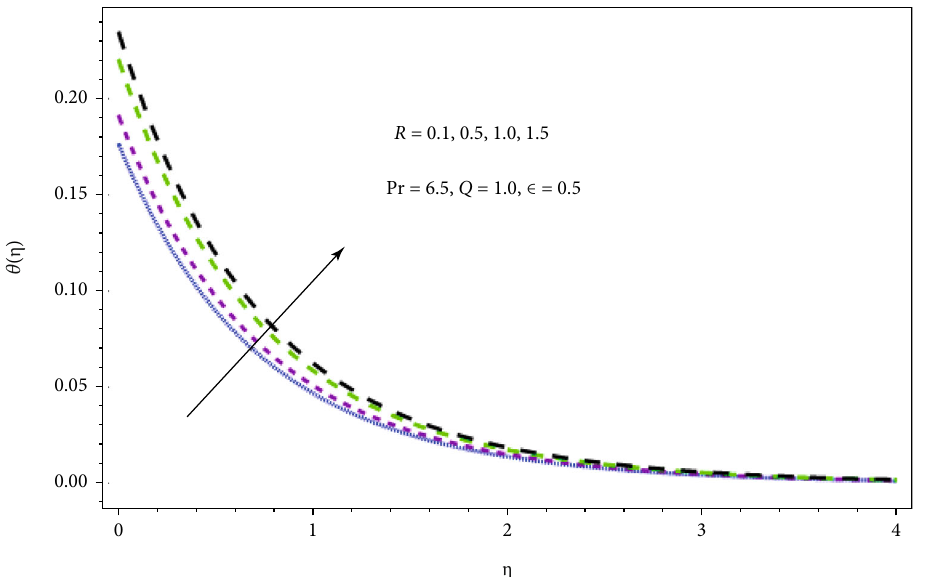
Figure 7: Representation of the e ff ect of R on θ ð η Þ